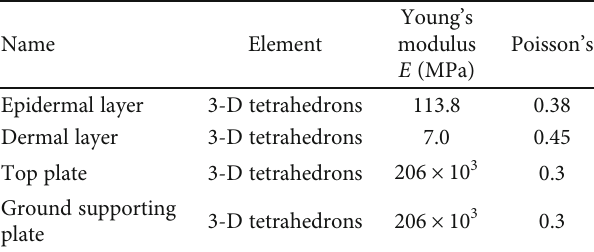
Table 2: Material properties and types of the normal